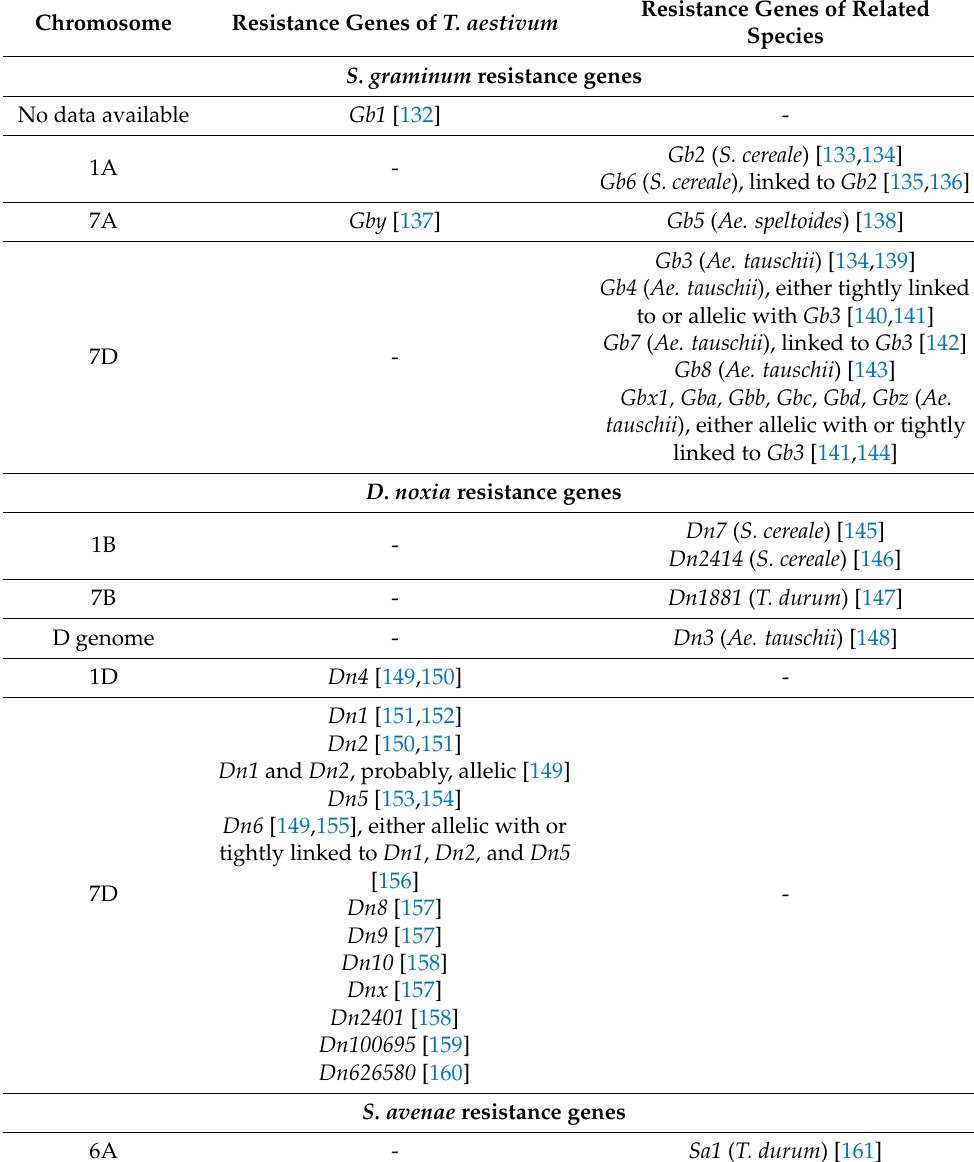
Table 1. Wheat aphid resistance